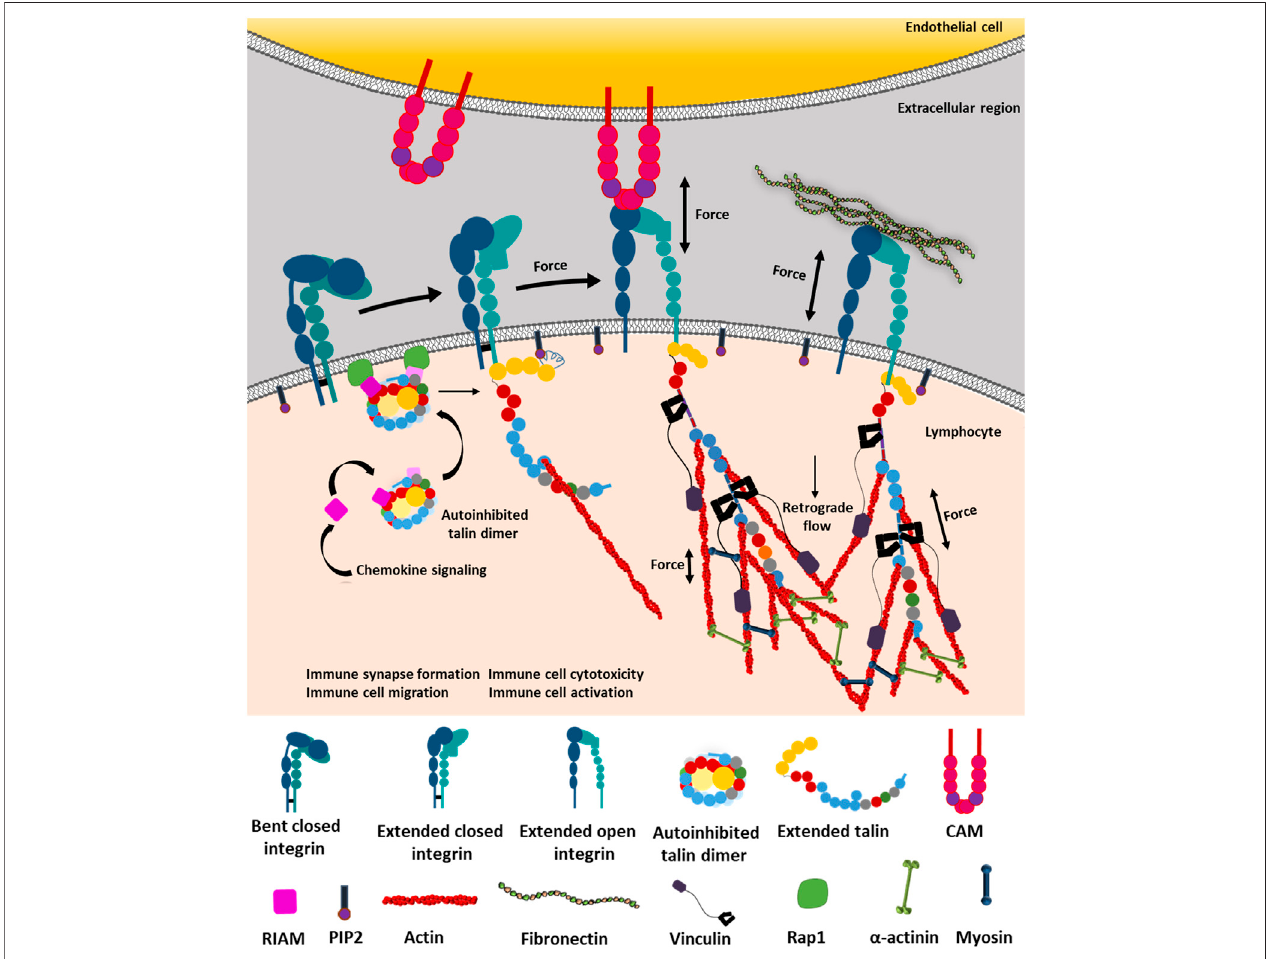
FIGURE1 | Integrin-dependentmechanotransduction byoutside-in and inside-outsignaling. Integrin can exist betweenthree conformationalstates: bent-closed, extended-closed, and extended-open conformation. Bent-closed conformation is functionally inactive and thus could not interact with cell – extracellular matrix (ECM) ligands. Chemokine signaling initiates RIAM to bind the autoinhibited talin. The autoinhibited talin – RIAM complex binds to the Rap1 protein, which activates talin by extending itfrom the autoinhibited structure. Subsequently, the extended talin binds to the NPxY motif ofthe cytosolic tail of the β subunit of integrin. Talin binds to PIP2bytheFERMdomain(redpentagon) andactinbyitsactin-bindingdomains.Theseinteractionsbreakthetransmembranesaltbridgebetween α and β subunitsand activate integrin by providing the required force, which allows integrin to cross its internal thermodynamic barrier, resulting in the active state stabilization by the very low force provided by talin. Now activated integrin is able to bind ECM ligands on the extracellular region connected to the actomyosin complex inside the cell. On the contrary, integrin also gets activated from the extended-closed structure through outside-in force sensing by forming interacting bonds with its intercellular ligands like CAMs or ECM proteins. The thermodynamic barrier causes conformational fl uctuation between the most stable bent-closed to unstable extended-open conformation throughatransientextended-closedstate.Whileexperiencingligandsoutsidethecell,theextended-closedconformationhastheabilitytoformatransientbondwiththe ligand (here CAM), which transmits the force through integrin to talin. Talin along with PIP2 breaks the transmembrane salt bridge, activating the integrin to extended- open conformation. This isfollowed by the binding ofthe actin cytoskeleton totalin. Thisprovides longer and more durable catch-bond formation, under force,between the integrin-extracellular ligand, thus transducing the signaling cascades and retrograde fl ow to regulate immune synapse formation, activation of lymphocytes, tissue invasion by migration, cytotoxicity, etc. (Or ł owski et al., 2015b; Haining et al., 2016; Yao et al., 2016; Khan and Goult, 2019; Sun et al., 2019).